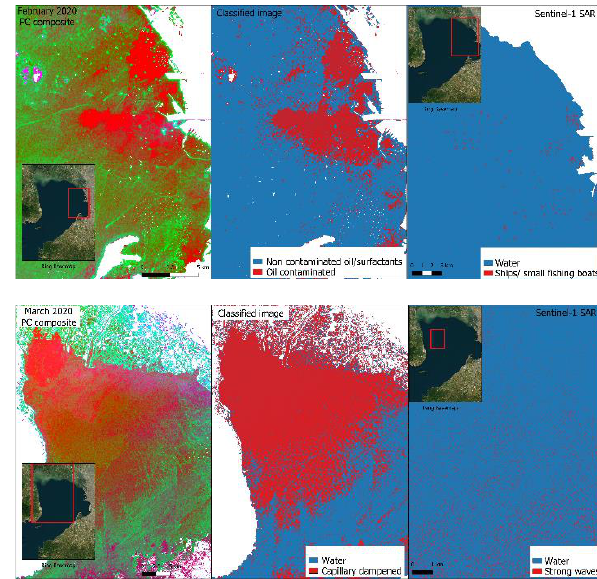
Figure 10. Top: January 2020 - Oil/surfactant pixels were found in the same area as increased ship occurrence in Bataan. Middle: February 2020 - Like the previous image, oil/surfactant pixels were found in Metro Manila near increased ship occurrence. Bottom: March 2020 – Unlike the previous two images, the radar image did not contain any formations resembling ships. While no evidence of strong backscatter indicative of ships was found, a strong backscatter indicates strong winds (Gao et al., 2021), which resulted in the wide distribution of possibly surfactants originating in aquaculture